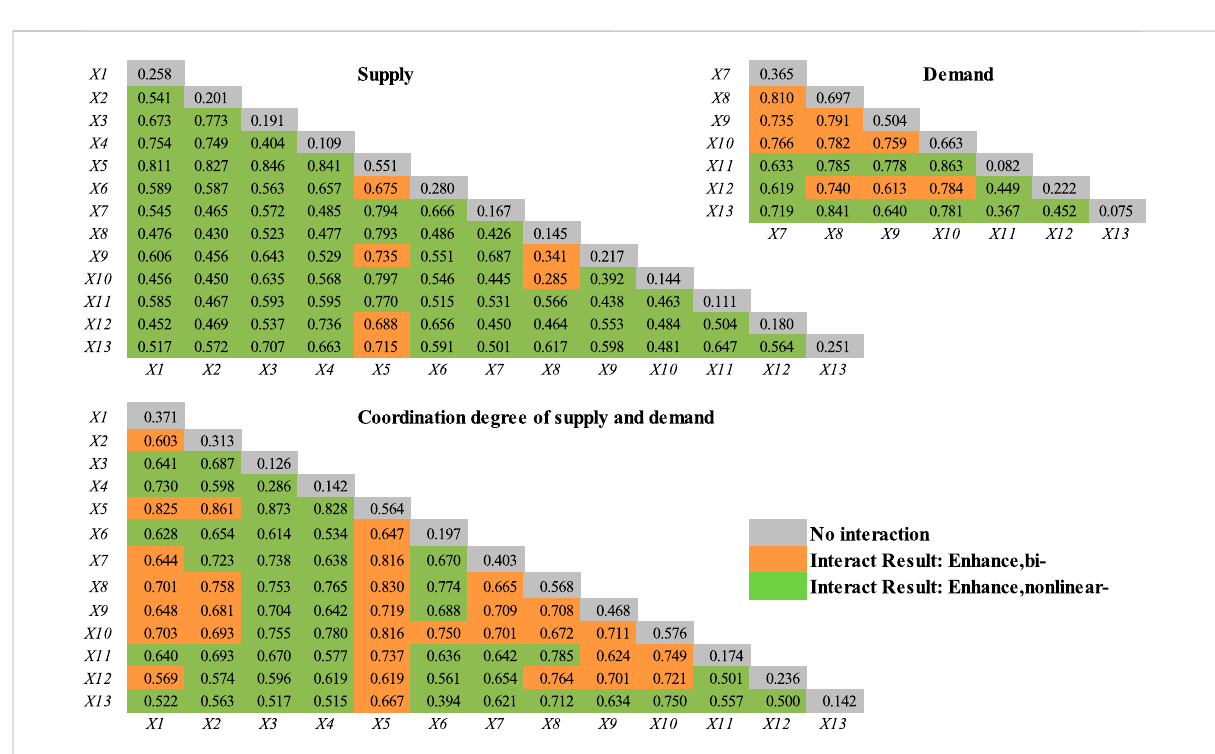
FIGURE 7 Interactions between the driving factors of the supply – demand relationship of ecosystem